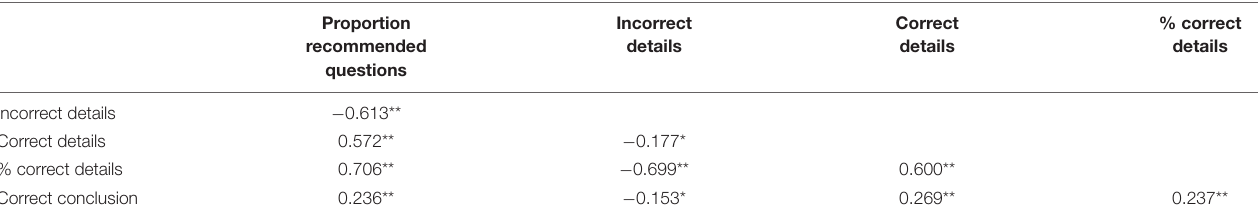
TABLE 2 | Pearson correlations between proportion of recommended questions and correct and wrong details being elicited from the avatar as well as number of correct conclusions reached ( n =